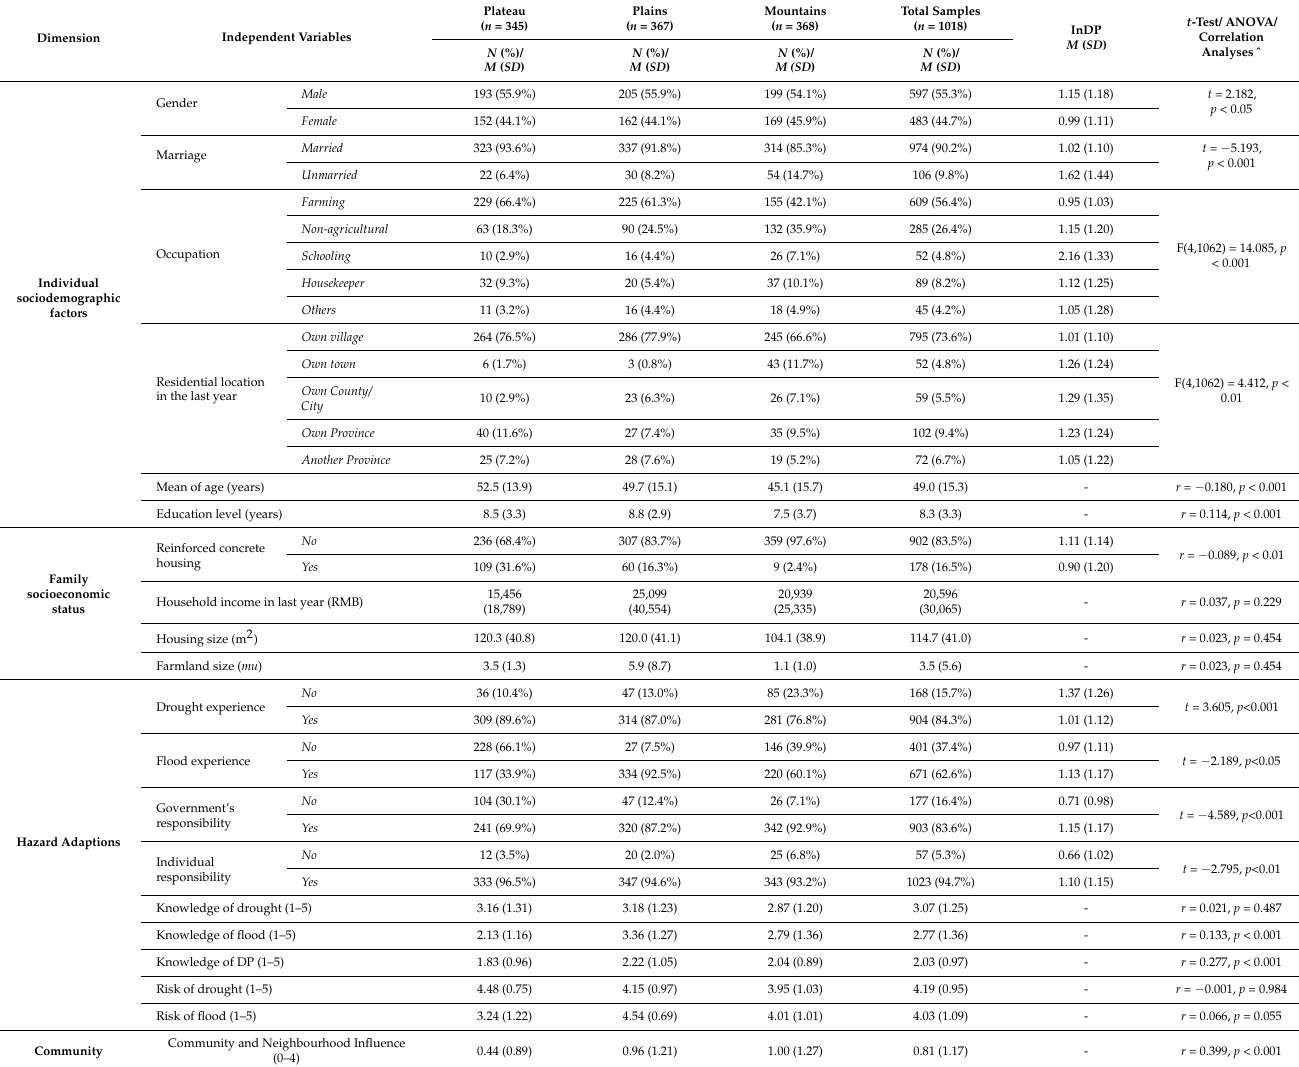
Table 1. Descriptive analyses of the samples and individual disaster